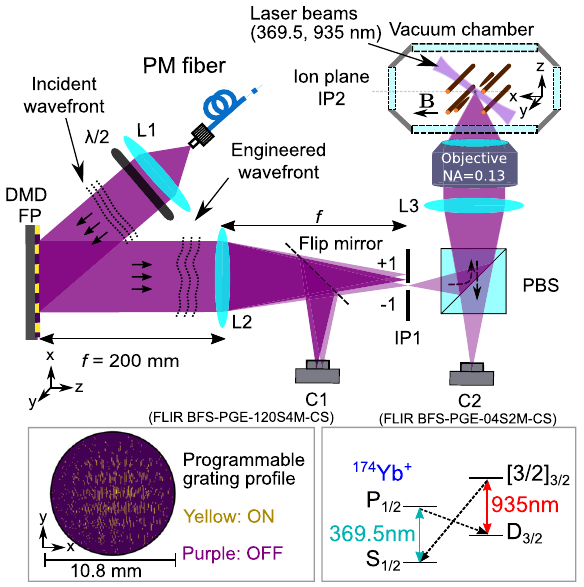
Fig. 1 Experimental setup. The s -polarized 369.5 nm output beam from the fi ber is expanded by the collimating lens L1 to a 5 mm (1/ e 2 intensity radius) Gaussian beam illuminating a circular aperture on the DMD at an incident angle of ~24 ∘ . A fl ip mirror can direct the light onto a camera C1 to monitor the optical intensity pro fi le and characterize aberrations at IP1. A CMOS camera (C2) is used to detect fl uorescence from the ion. The DMD beam is introduced into the fl uorescence-imaging path through a polarizing beam splitter (PBS). Ion addressing and fl uorescence collection are achieved using a shared off-the-shelf objective (Thorlabs LMU-5X-NUV) and an imaging lens L3. The effective focal length between the DMD FP and IP2 is 39.9 mm. Here, we choose a coordinate system convention where the beam is propagating along the z direction. A magnetic fi eld B ^ x ð(cid:4) 2G Þ is applied to the ion to prevent it from going into a coherent dark state. An example DMD hologram and a simpli fi ed energy level diagram of 174 Yb + are shown at the